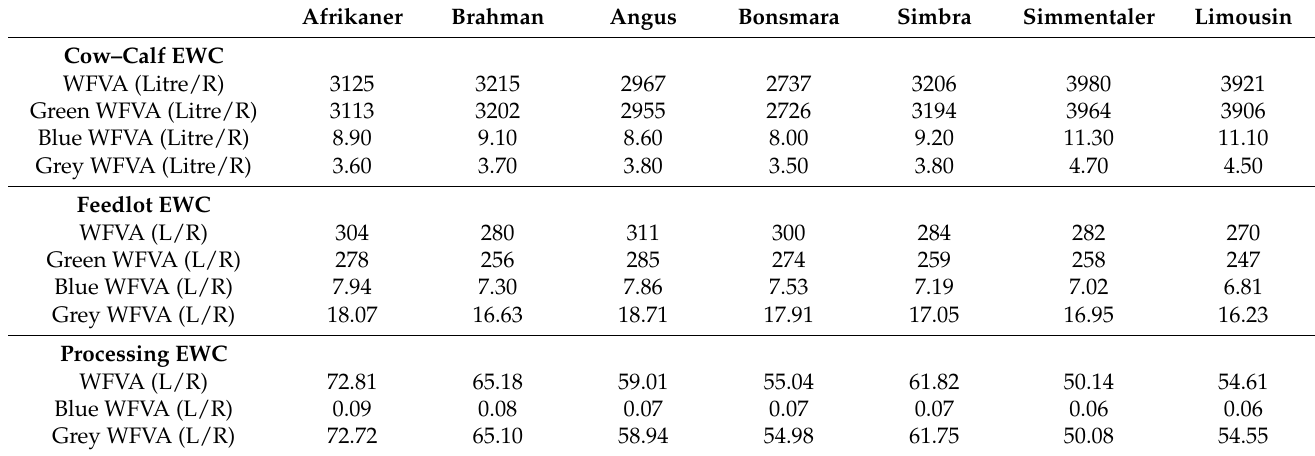
Table 6. Economic water consumption of the different breeds and value chain